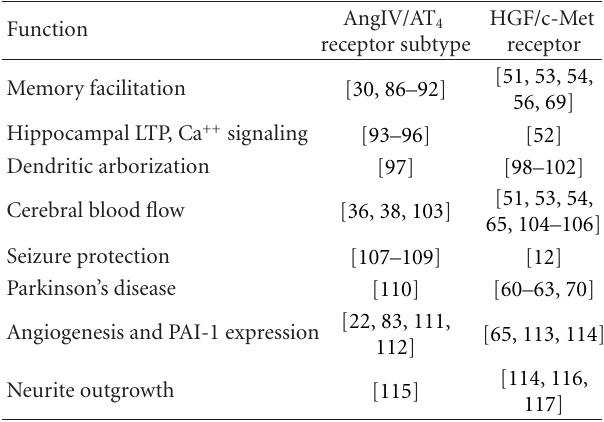
Table 3: Summary of overlapping functions associated with the AngIV/AT 4 receptor subtype and the HGF/c-Met